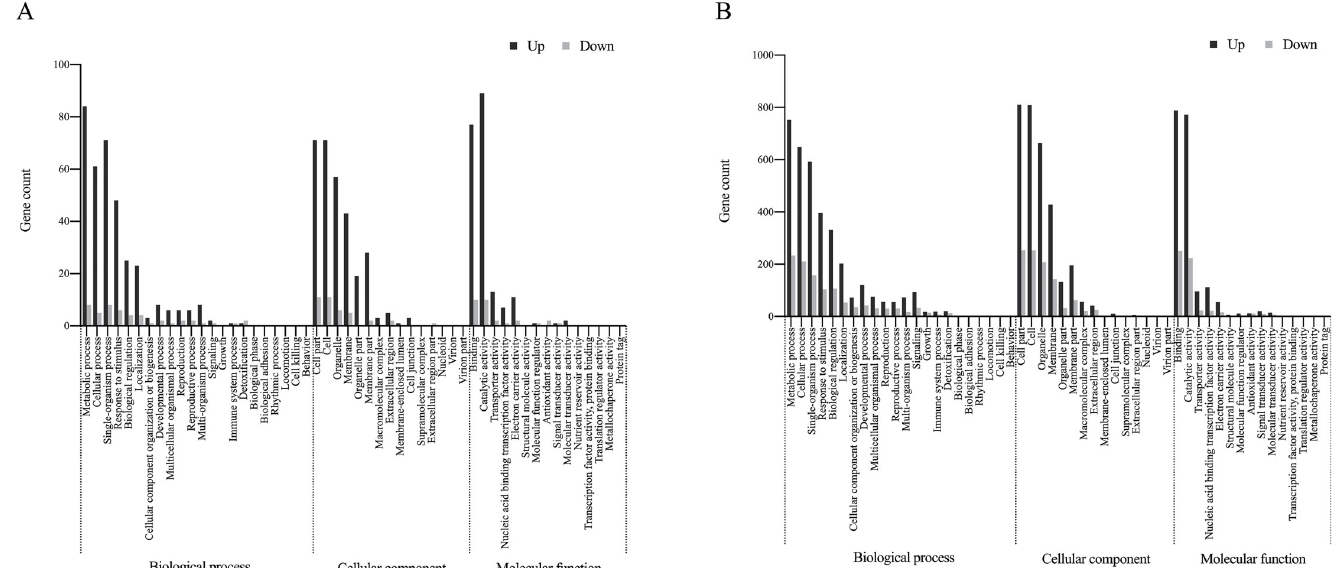
Fig 3. GO analysis of DEGs in the leaves in the nonuniform salinity treatment (0/200) ( A ) and uniform salinity treatment (100/100) ( B ), as determined by RNA-seq. The abscissa of the bar plot represents the gene count within each GO category. All processes listed presented enrichment when P < 0.01.